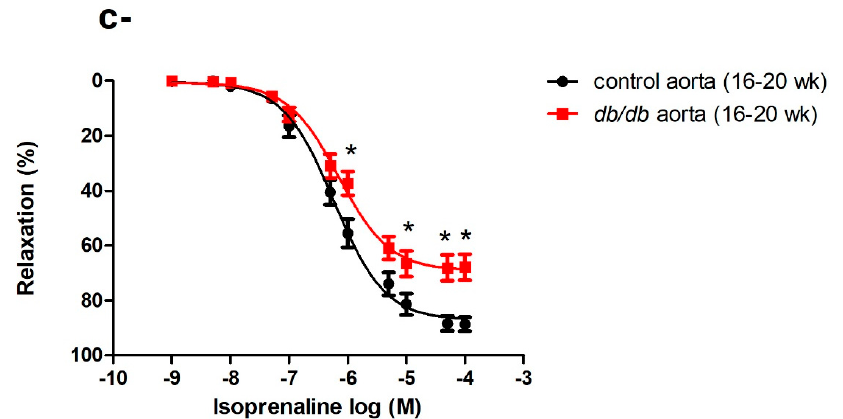
Figure 5. Generalized vascular dysfunction in in the aortae of db / db mice. ( a ) E ff ects of apocynin, indomethacin, L-NAME, and tempol on ACh-induced vasodilatation in the aortae of db / db mice at